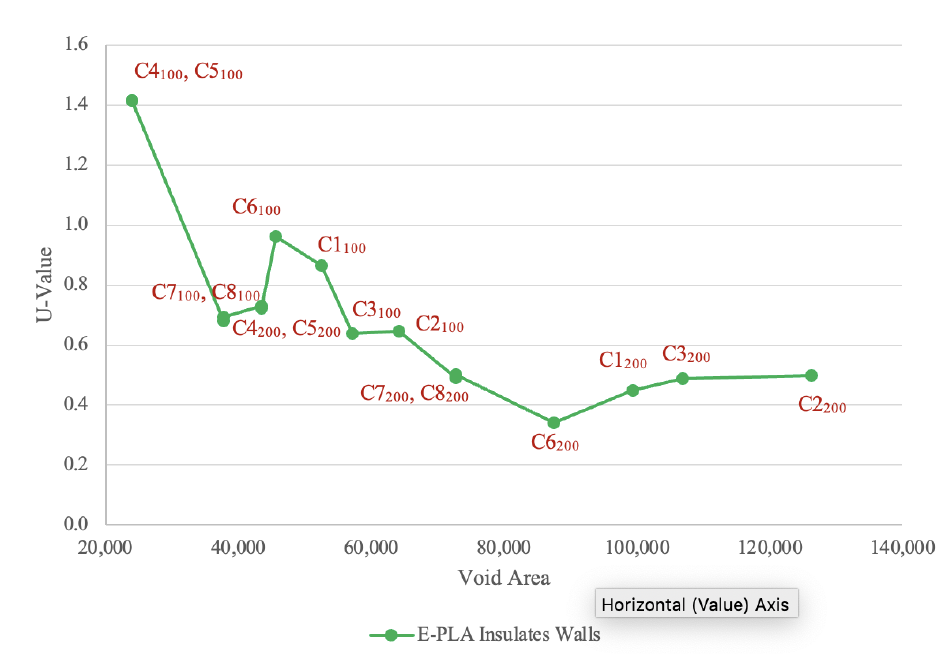
Figure 10. The U -value variation with cavity